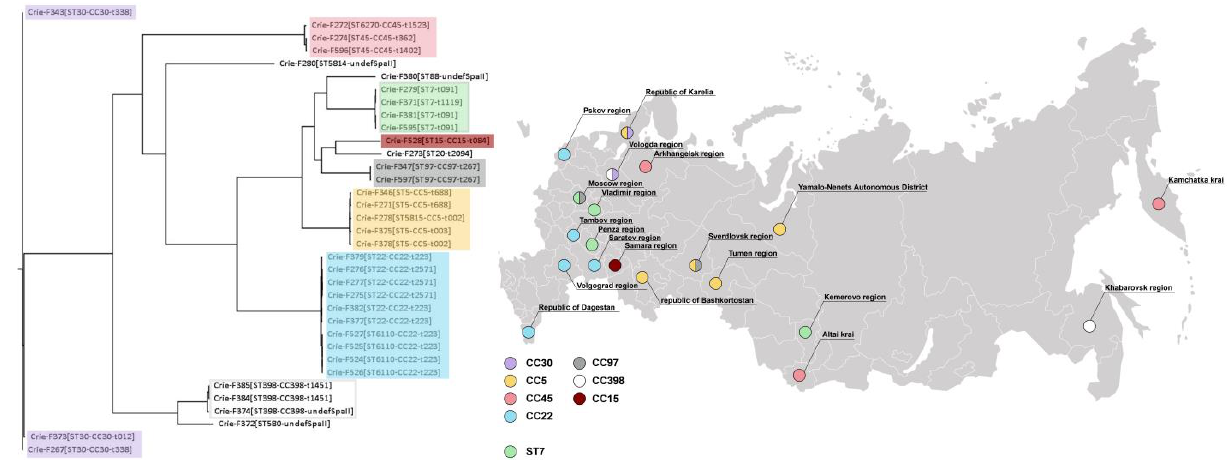
food Figure 1. Typing, geography, and phylogenetic analysis of S. aureus isolates from ready-to-eat (RTE) food studied.